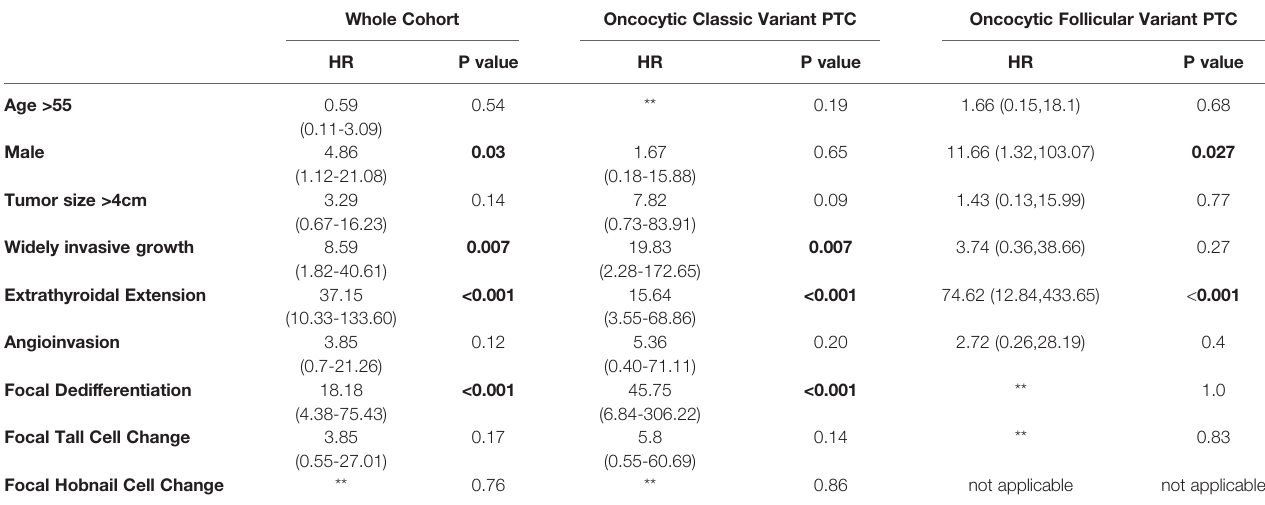
TABLE 2 | Univariate analysis of factors associated with locoregional recurrence in patients with oncocytic classic variant and oncocytic follicular variant papillary thyroid carcinoma (PTC). Whole